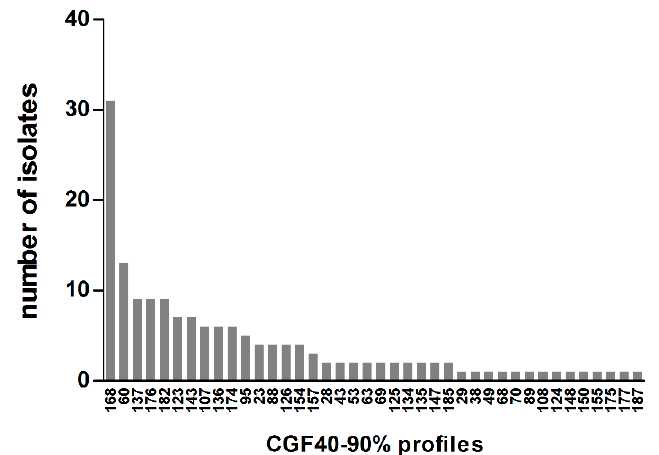
Figure 4. Distribution of CGF40-90% profiles within 161 C. jejuni isolates from cats and dogs in France. Labels on the X-axis correspond to the CGF40-90% cluster number.